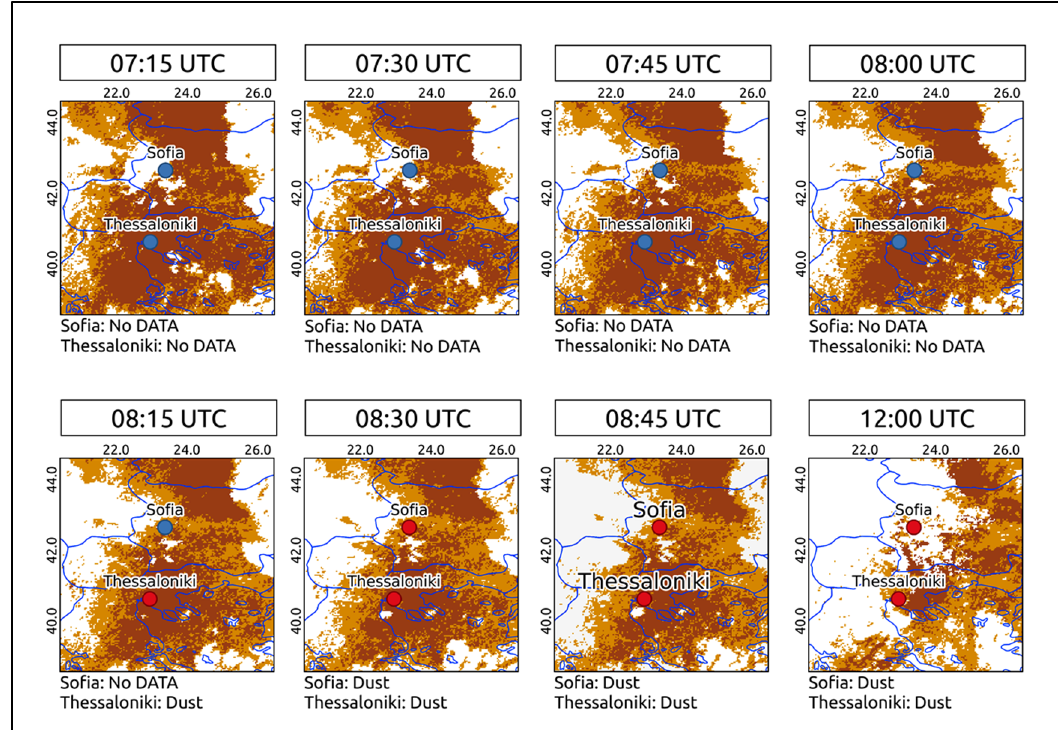
Figure 8. e RST DUST maps from SEVIRI data on May 20 between 07:15 UTC and 12:00 UTC. Red bullets indicate the time when lidar measurements were in progress at Thessaloniki and Sofia.